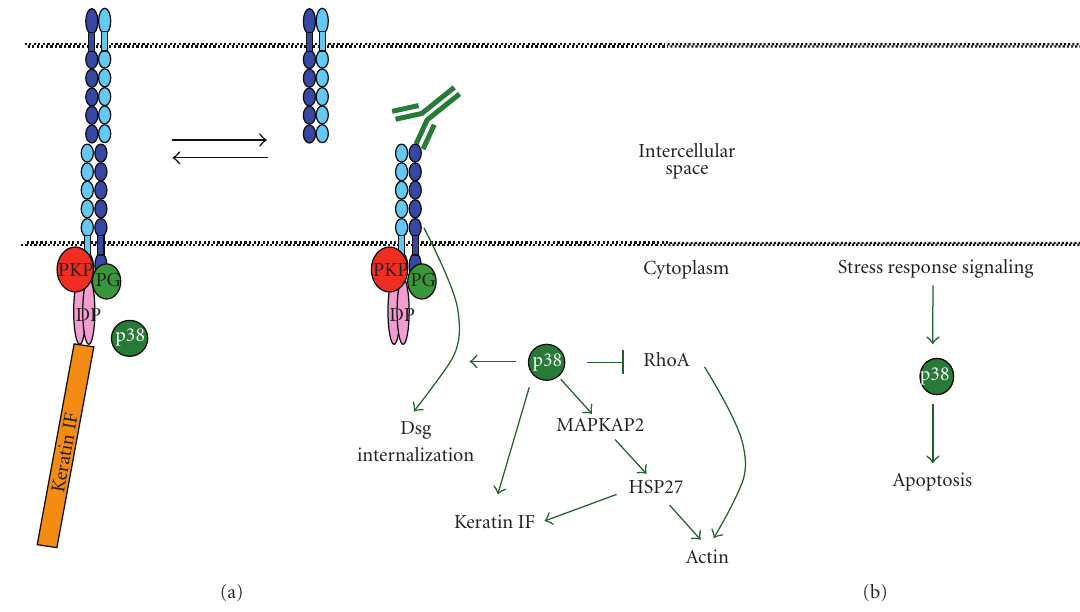
Figure 1: Pemphigus, p38MAPK, acantholysis and apoptosis. Two sequential peaks of p38MAPK activation are observed when keratinocytes are exposed to either PV or PF IgG. (a) Pemphigus IgG binds to dsg and biases the equilibrium of desmosome assembly/disassembly towards disassembly which is linked by an, as yet, undefined mechanism towards activation of p38MAPK. Subsequent p38 dependent alterations in the cell state include RhoA inactivation, dsg endocytosis, HSP27 phosphorylation, keratin intermediate filament retraction, actin, and loss of cell-cell adhesion (acantholysis). (b) A second late peak of p38 activity is observed that is likely a stress response signal induced by loss of cell-cell adhesion and leads to activation of proapoptotic pathways including caspase-3 activation.